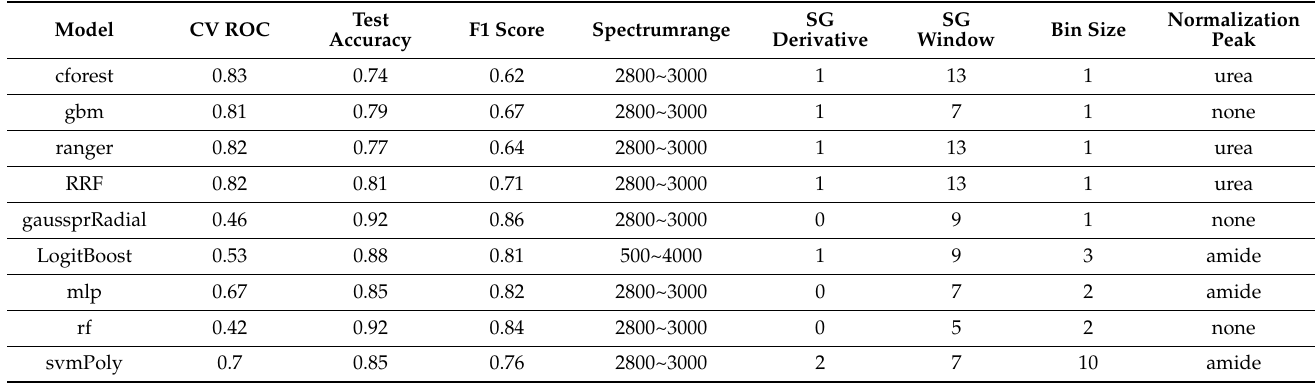
Table 3. Models selected for further validation with their processing parameters.